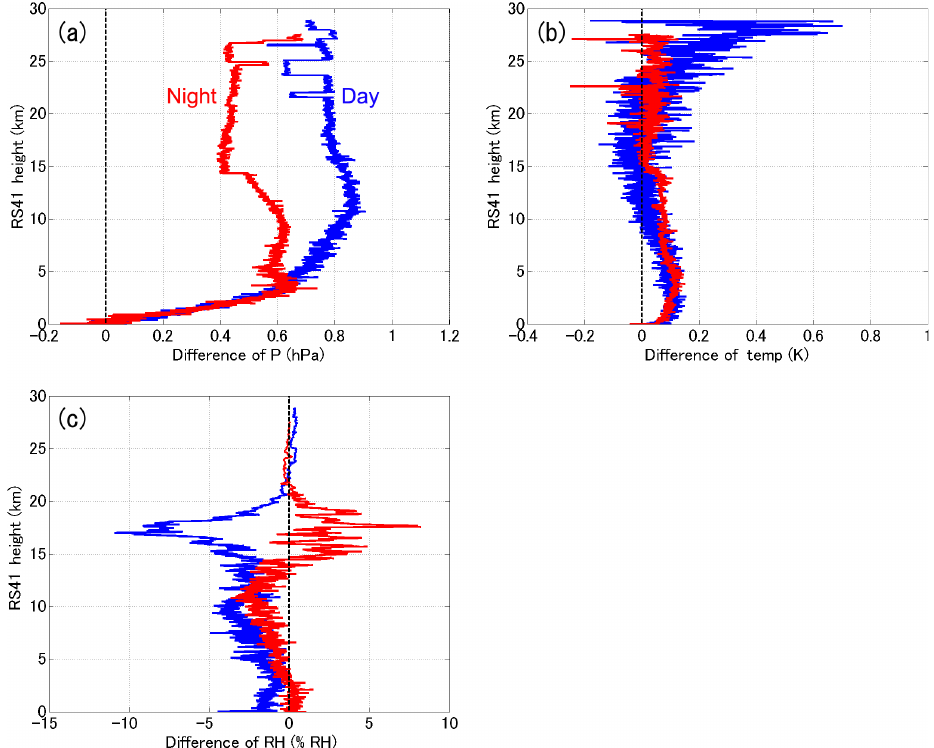
Figure 8. Differences between the RS92 and RS41 radiosonde (RS92–RS41) results for daytime (blue) and nighttime (red) flights during the MR15-04 cruise for (a) pressure, (b) temperature, and (c) relative